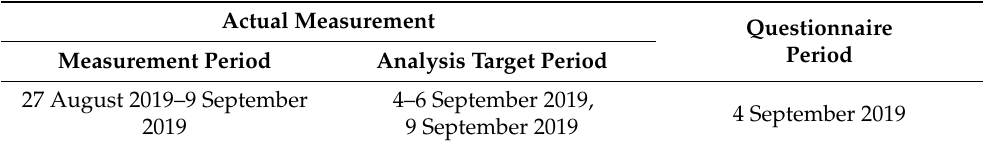
Table 2. Measurement and questionnaire distribution period.